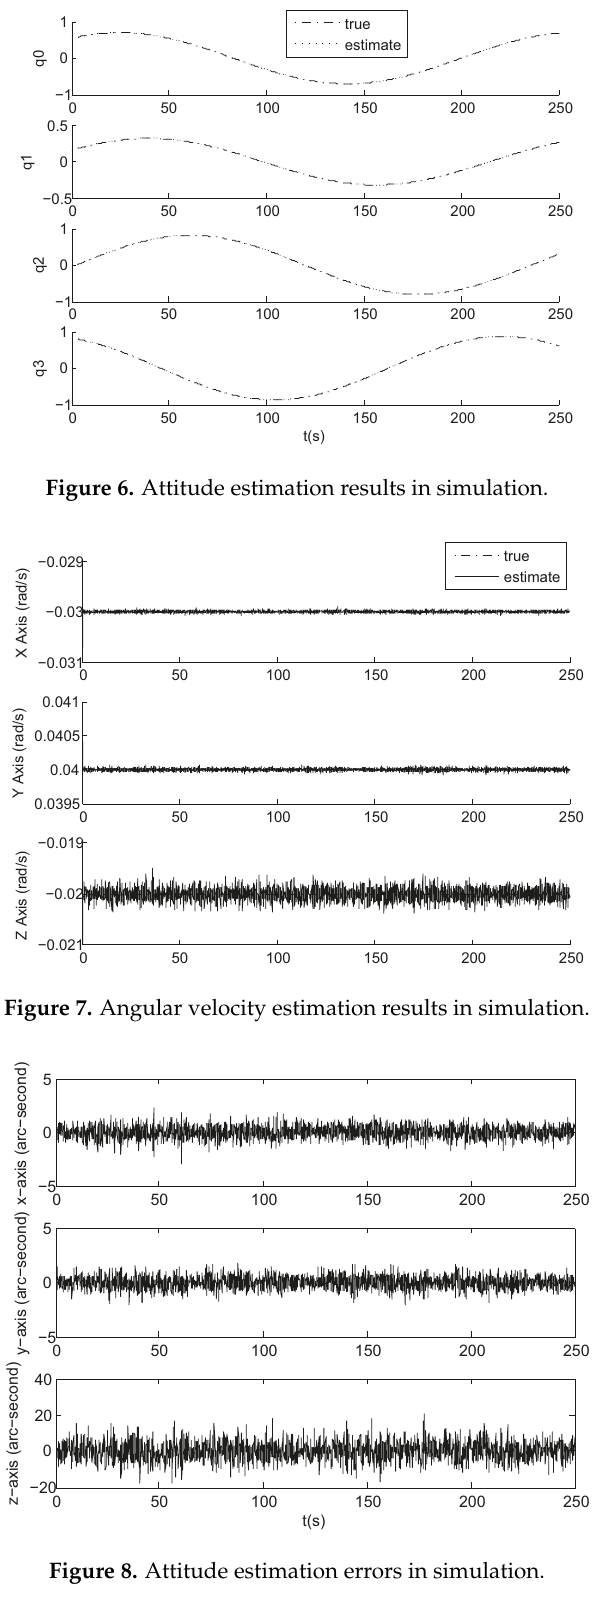
Figure 9. Angular velocity estimation errors in simulation. Figure 10. Maximum prediction error of the star locations in simulation.